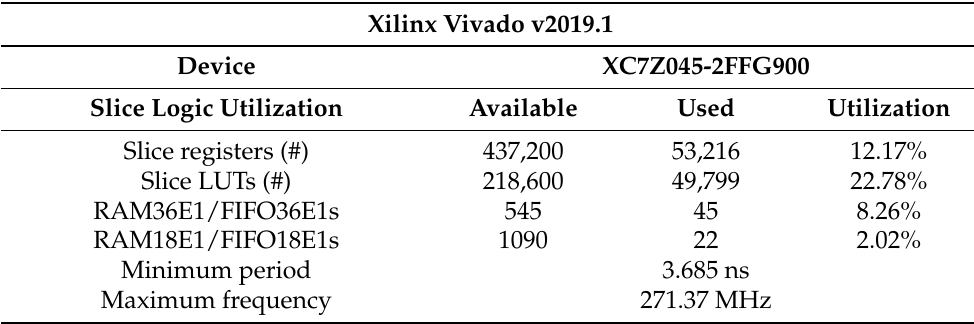
Table 3. Hardware implementation results for the proposed autonomous dehazing system. LUT stands for look-up table, and the symbol # denotes quantities.